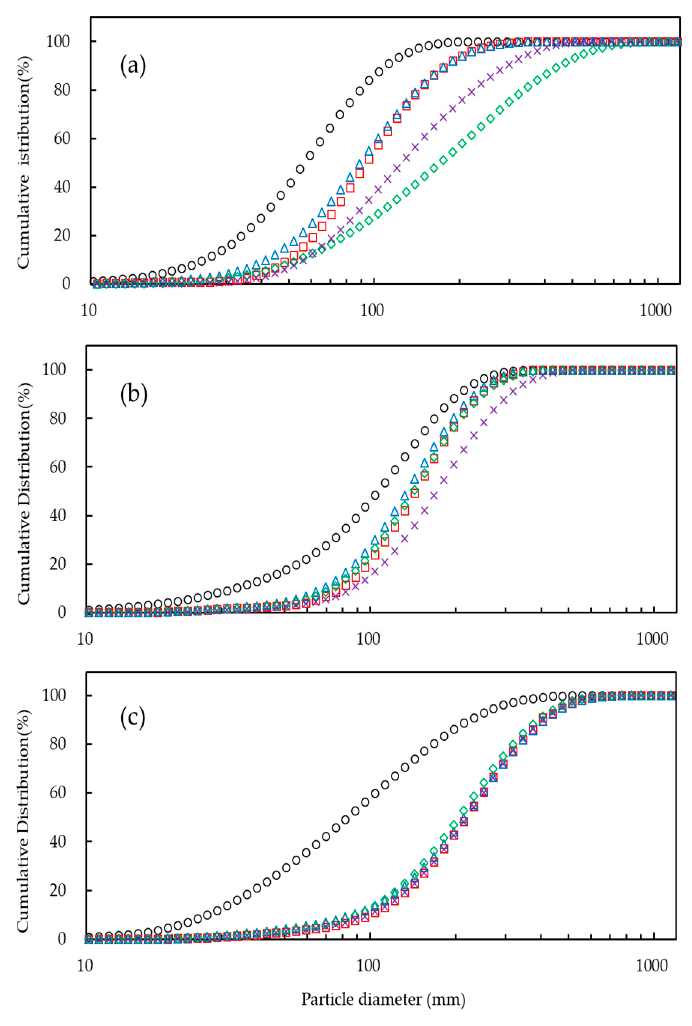
Figure 1. Cumulative distribution of fine gum powders ( ○ ) and gum agglomerates ( a ) GG, ( b ) LBG, and ( c ) CMC with different binders: ( □ ) glucose, ( △ ) sucrose, ( ◇ ) lactose, and (×) sorbitol. The span values (1.11–1.32) of the LBG and CMC agglomerates were much lower than those (1.60–2.37) of the fine powders, showing that a narrow size distribution with homogenous particles occurred when using a sugar binder (Table 1). In contrast, the span values (1.54–2.31) of the GG agglomerates (except for the one with glucose) were much higher than that (1.48) of the fine powder. In addition, all of the agglomerates showed large variations in span value regardless of the sugar type. The higher span values could be due to the mixing of small agglomerates with large agglomerates due to the breaking up of the latter during the agglomeration process. In general, the span values of the ag- glomerates increased in the order of LBG (1.11–1.32) < CMC (1.38–1.50) < GG (1.39–2.31), again showing dependency on the gum type. This is probably because GG is more friable than the others due to stronger friction between the particles and between them and the product vessel caused by the high-pressure airflow [22]. In particular, among the agglom- erates, the GG agglomerate with lactose with the highest span value (2.31) had the widest PSD. Thus, the span was greatly influenced by the strength of the bridge structures con- necting the primary particles with the sugar binder [4,23]. According to Johansen and Schæfer [20], the agglomerates can simultaneously be broken up and grow due to both friction forces and particle coalescence in the granulator. Therefore, GG was more friable than the others due to higher friction forces between the particles and between the parti- cles and the fluidizing vessel [22]. A similar result was also reported for agglomerated